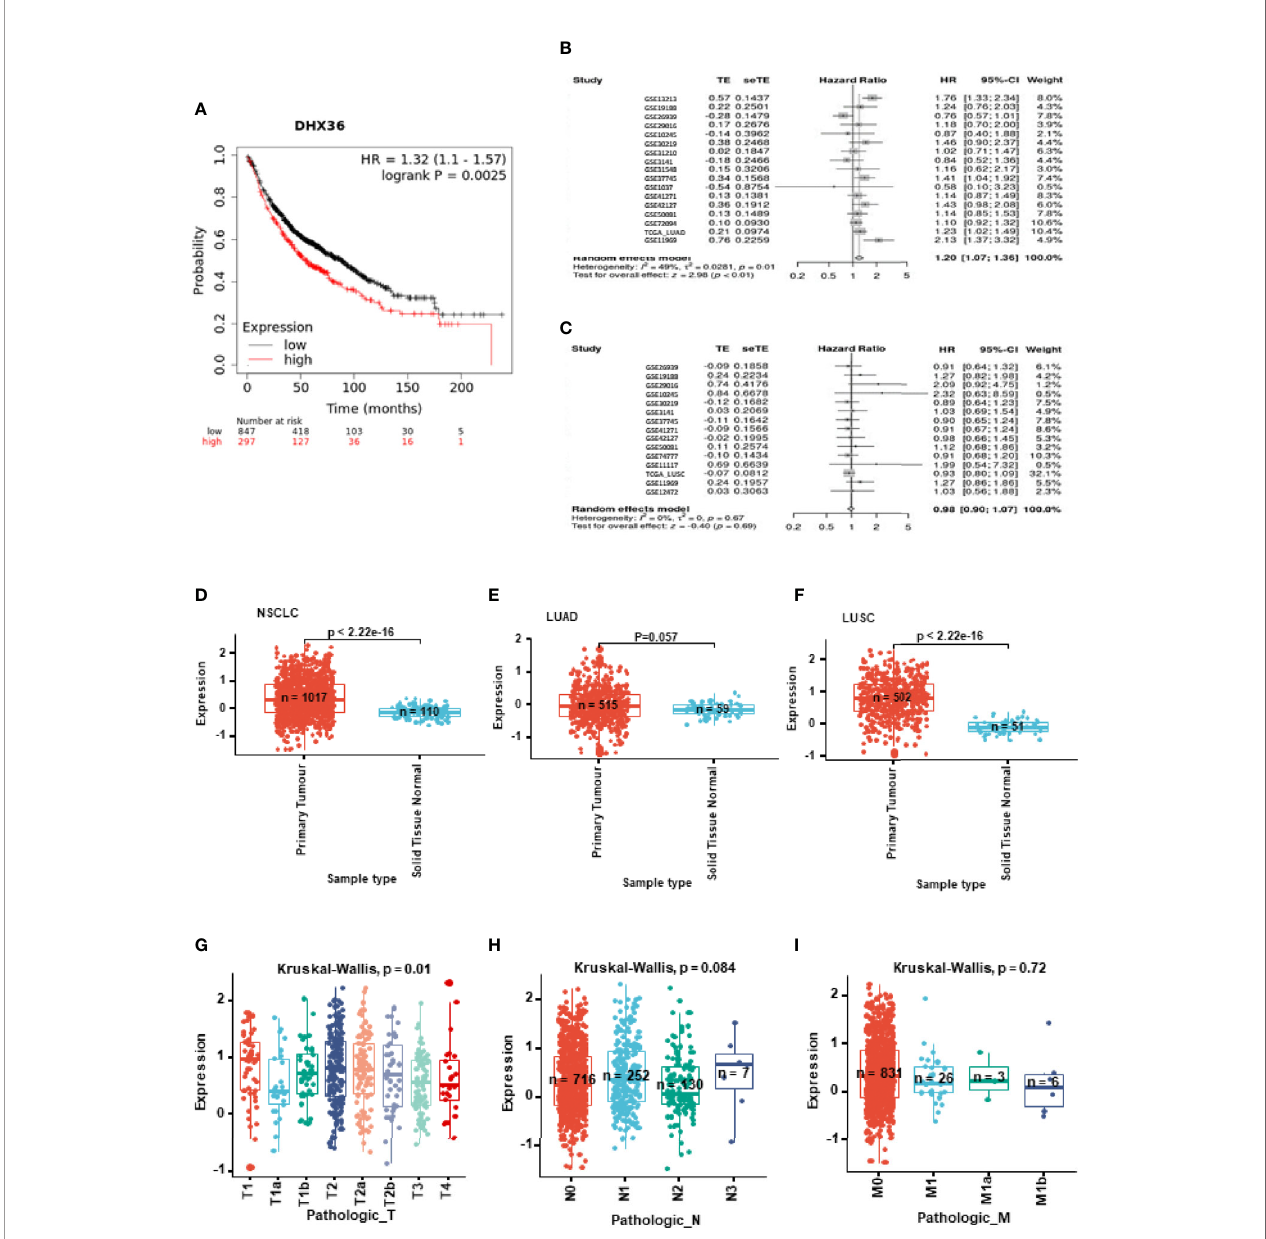
FIGURE 1 | Clinical signi fi cance of DHX36 in lungcancer. (A) Overallsurvival analysis of DHX36 in lungcancer using the Kaplan-Meier plotter (https://kmplot.com). The probes of DHX36 were 223138_s_at, 223139_s_at and223140_s_at. The patients were splitbyAuto select best cut-off.The number of eligible patients was n=1144. The breakdownmeta-analysis of survival analysis inLUAD (B) and LUSC (C) was performed usingthe LungCancer Explorer (http://lce.biohpc.swmed.edu), which integrated the following eligiblegenomic data ofGSE72094 (n=442), TCGA (LUAD,n=576; LUSC, n=552),GSE30219 (n=307), GSE41271 (n=275),GSE31210 (n=224),GSE31210 (224), GSE37745 (n=196),GSE50081 (n=181),GSE42127 (n=176), GSE11969 (n=163),GSE19188 (n=156), GSE13213 (n=117), GSE3141 (n=111), GSE74777 (107), GSE26939 (n=101), GSE1037 (n=80), GSE29016 (n=72),GSE12472 (n=63),GSE31548 (n=50),GSE10245 (n=48) andGSE11117 (44). (D) Differential expression of DHX36 gene between tumourand normal tissues in NSCLC. (E) Differential expression of DHX36 gene between tumour andnormal tissues in LUAD. (F) Differential expression of DHX36 gene between tumour andnormaltissues inLUSC. (G) Differential expression ofDHX36 gene amongT staging types in NSCLC. (H) Differential expression of DHX36 gene amongN staging types in NSCLC. (I) Differential expression ofDHX36 gene amongM staging types